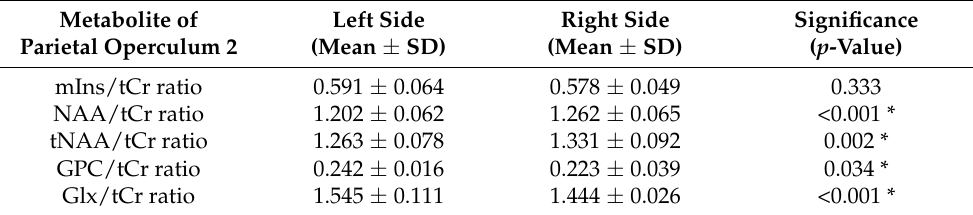
Table 2. Brain Metabolites of the Parietal Operculum 2 a .